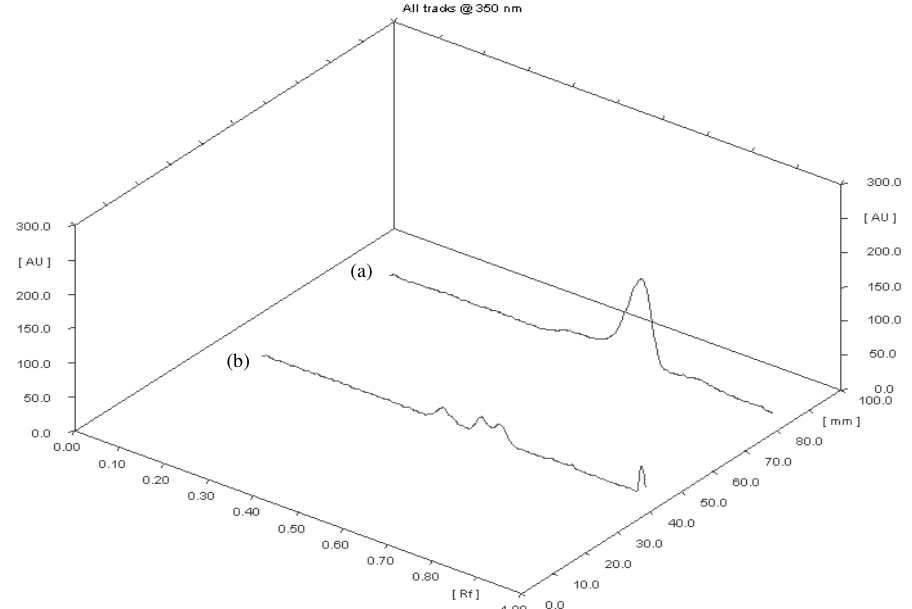
Figure 4. A typical HPTLC chromatogram of standard rutin and plant; a) standard rutin, b) FFHM.